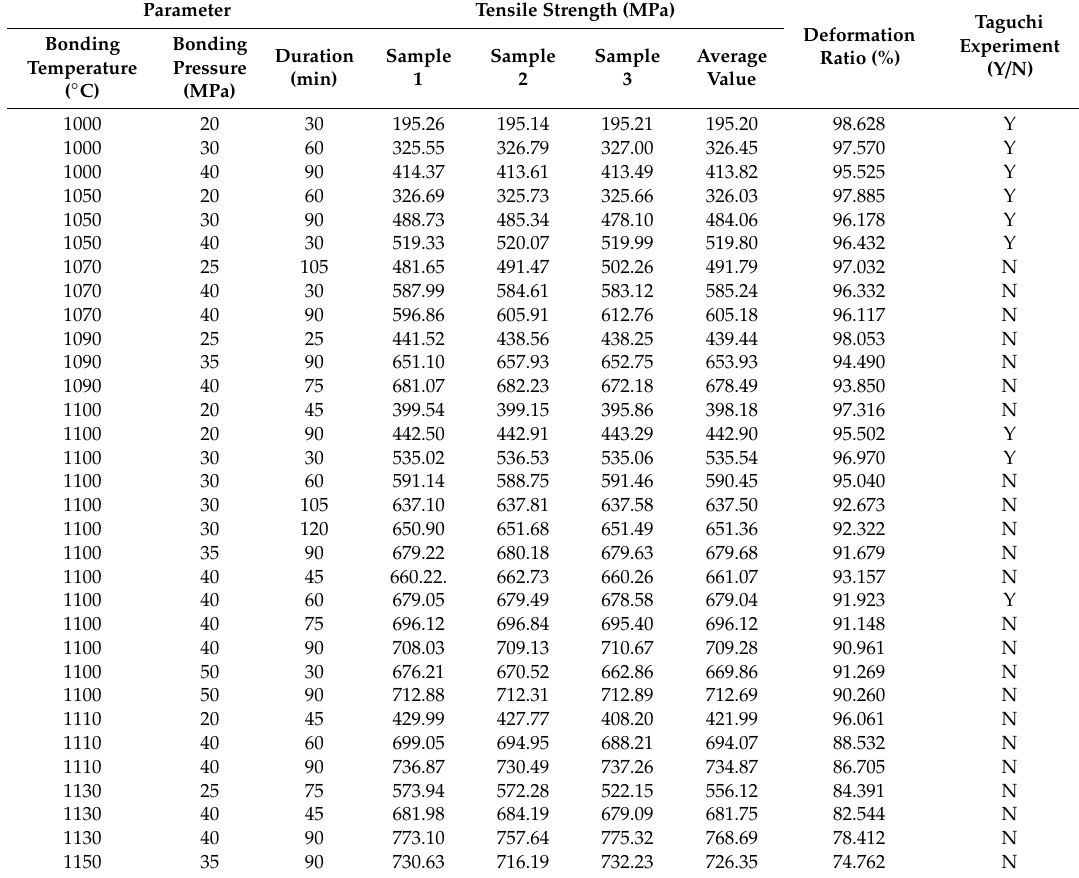
Table 2. Tensile strength and deformation ratio.